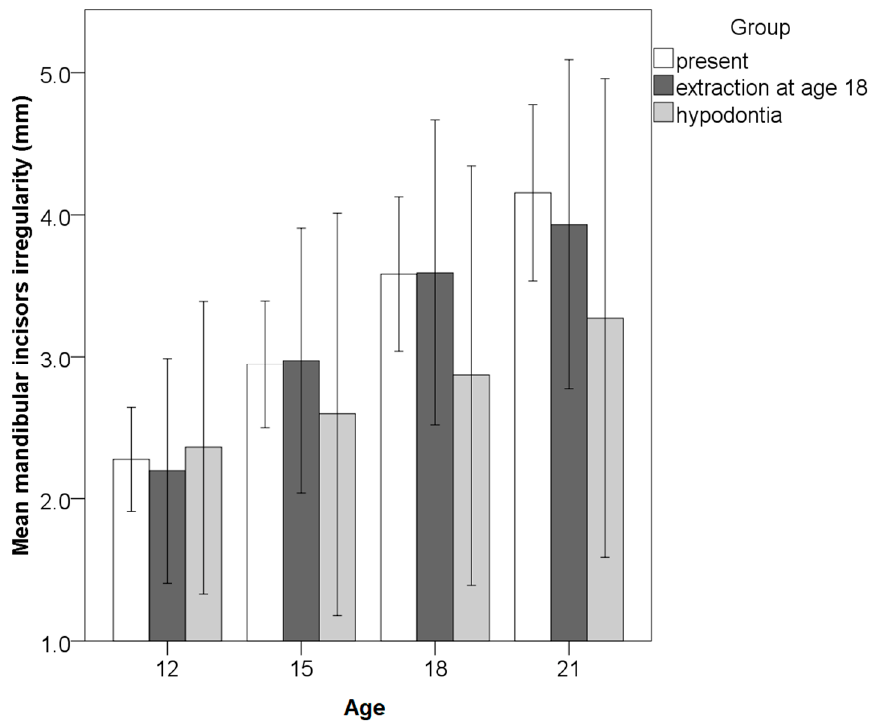
Figure 3. Comparison of mandibular incisor irregularity (The irregularity index) from the ages of 12 to 21 years between the groups with present, hypodontia or extracted third molars (whiskers present 95% confidence intervals).